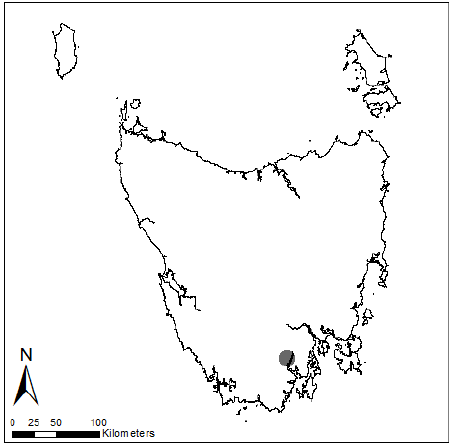
Figure 2. The state of Tasmania with a dot showing the location of the study